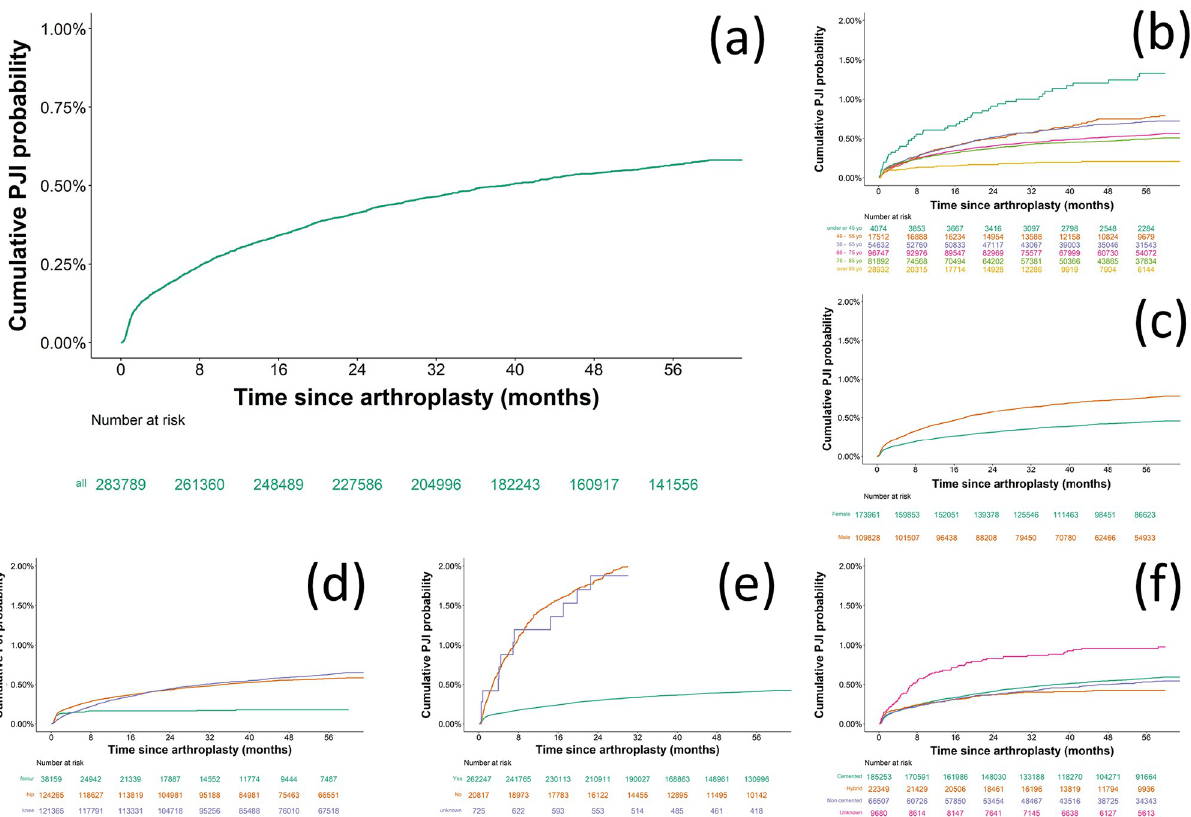
Fig 1. Example of Kaplan-Meier curves of cumulative risk of PJI for the entire cohort (a) and stratified based on age (b), gender (c), joint (d), primary/replacement surgery (e) and type of fixation (f).